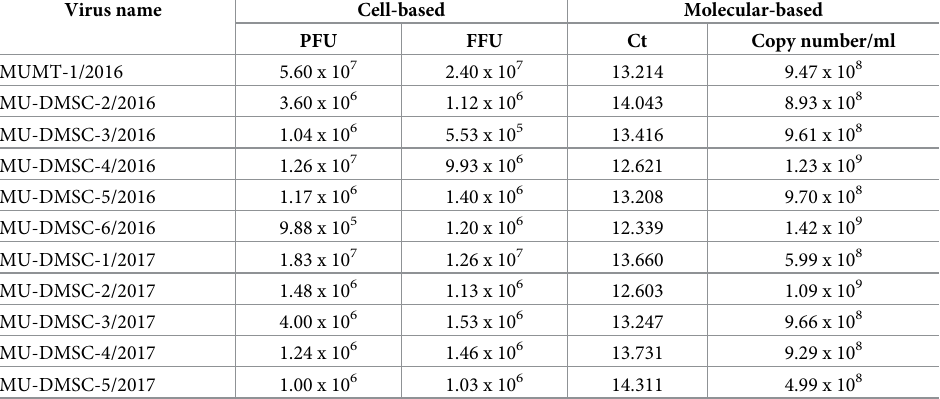
Table 2. Comparison of Zika viral titer between Plaque Forming Unit (PFU), Focus Forming Unit (FFU), real time RT-PCR (Ct) and droplet digital RT-PCR (copy